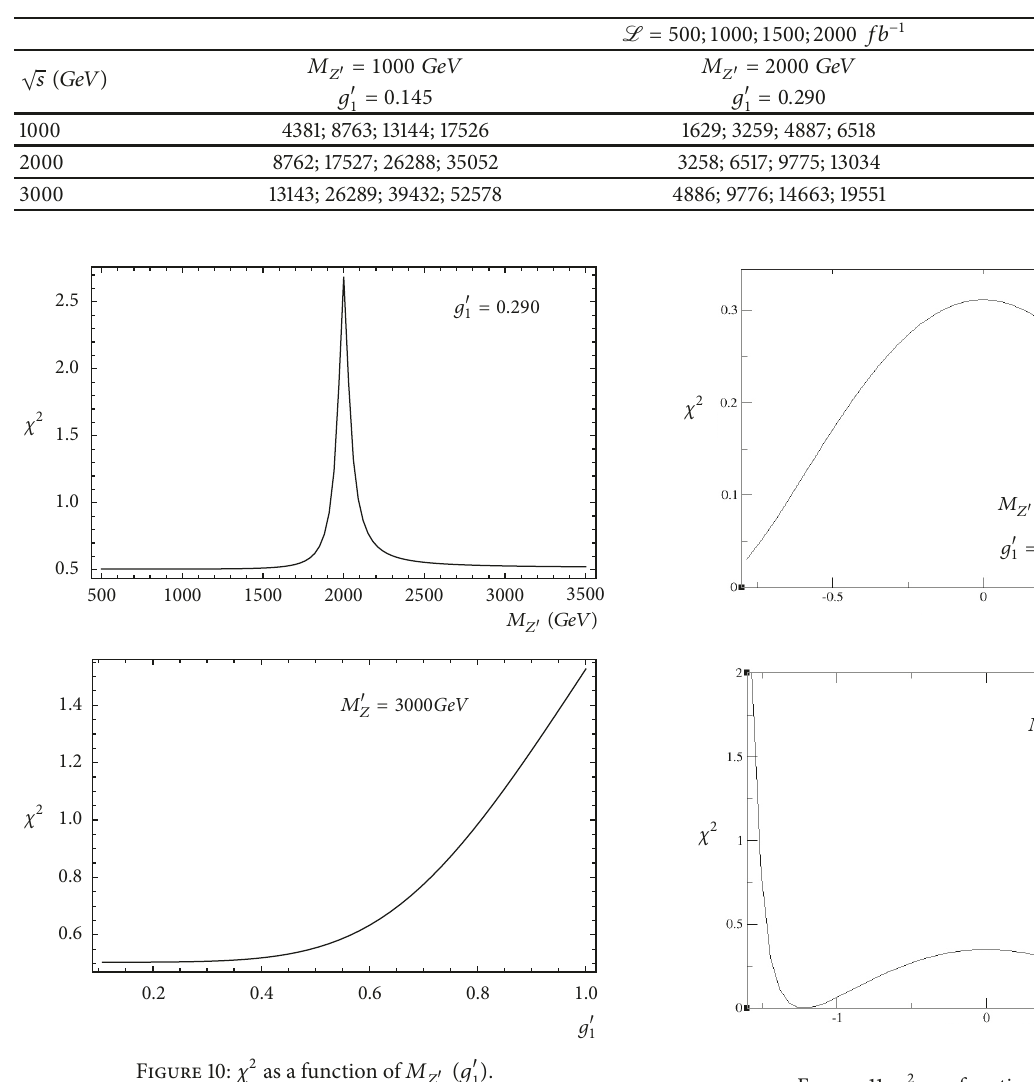
Table 4: Total production of 𝑡𝑡𝐻 in the B-L model for 𝑀 푍 󸀠 = 1000,2000,3000 𝐺𝑒𝑉 , L = 500,1000,1500,2000 𝑓𝑏 −1 , 𝑀 퐻 = 800 𝐺𝑒𝑉 , 𝛼 = 𝜋/9 and 𝜃 耠 = 10 −3 .